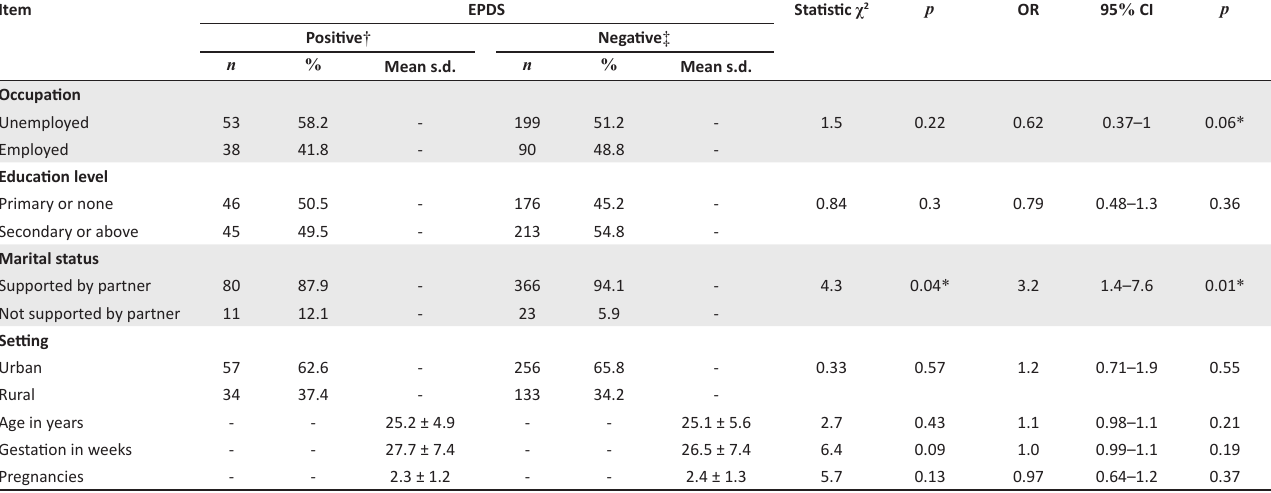
TABLE 1: Demographic and clinical characteristics of respondents ( n =